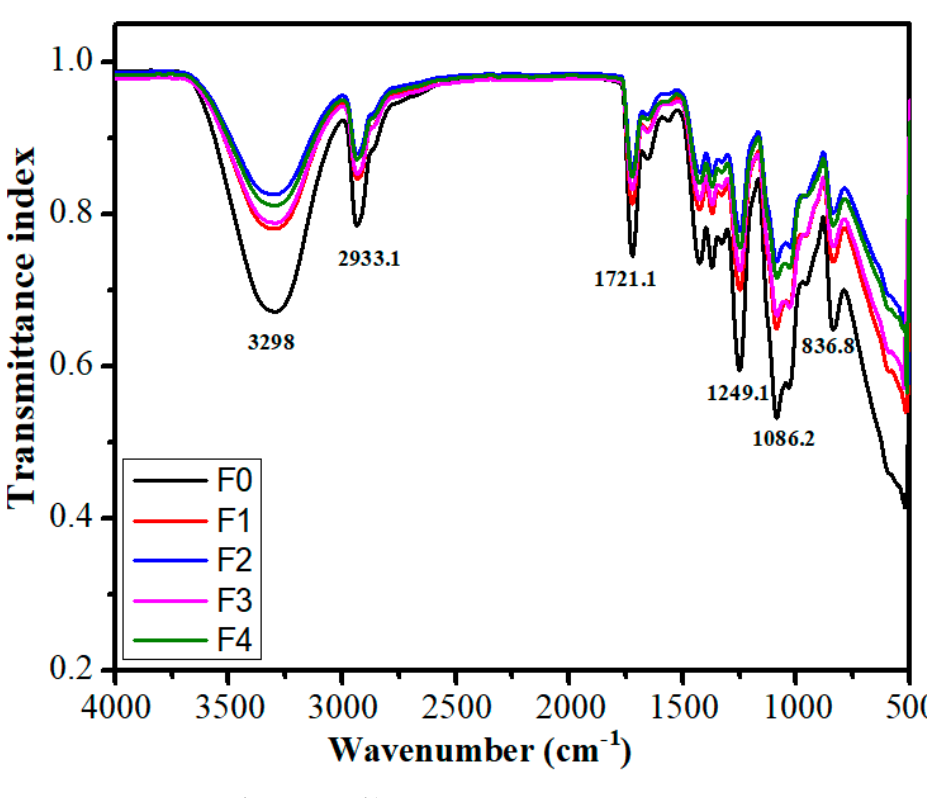
Figure 7. FTIR spectra of composite films. Table 2. Important peaks obtained from FTIR